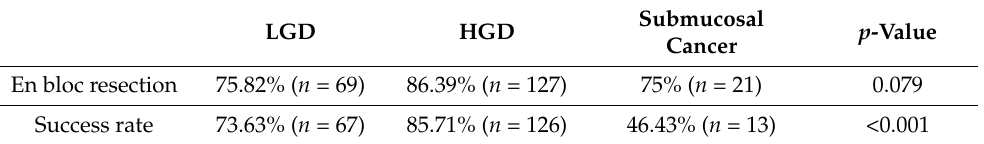
Table 3. Efficacy of ESD procedure depending on the histopathology assessment.